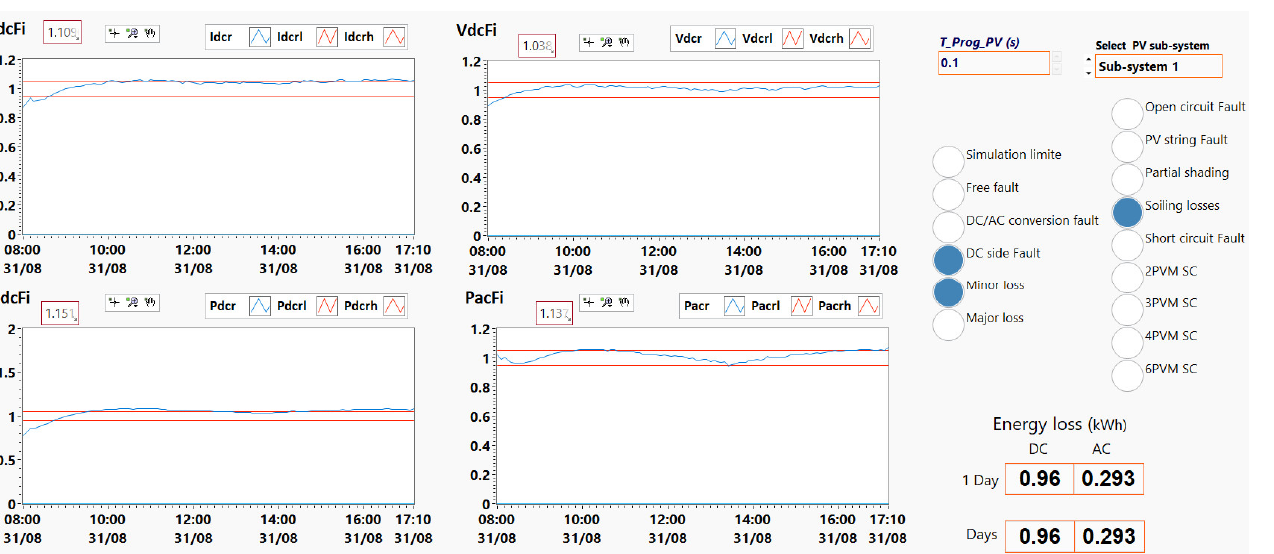
Figure 31. Identification of soiling losses caused by dust accumulation on the PV subarray